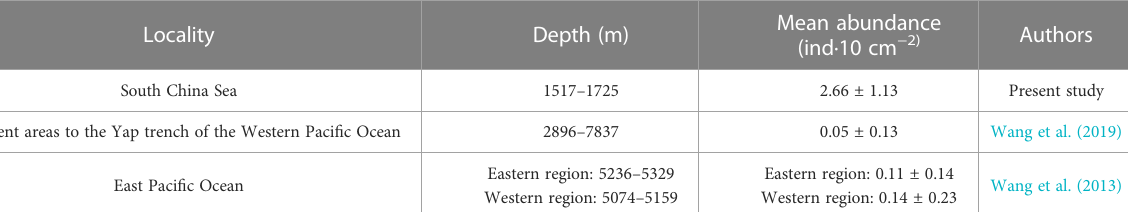
TABLE 6 Comparison of marine tardigrade studies in the South China Sea and other seas.